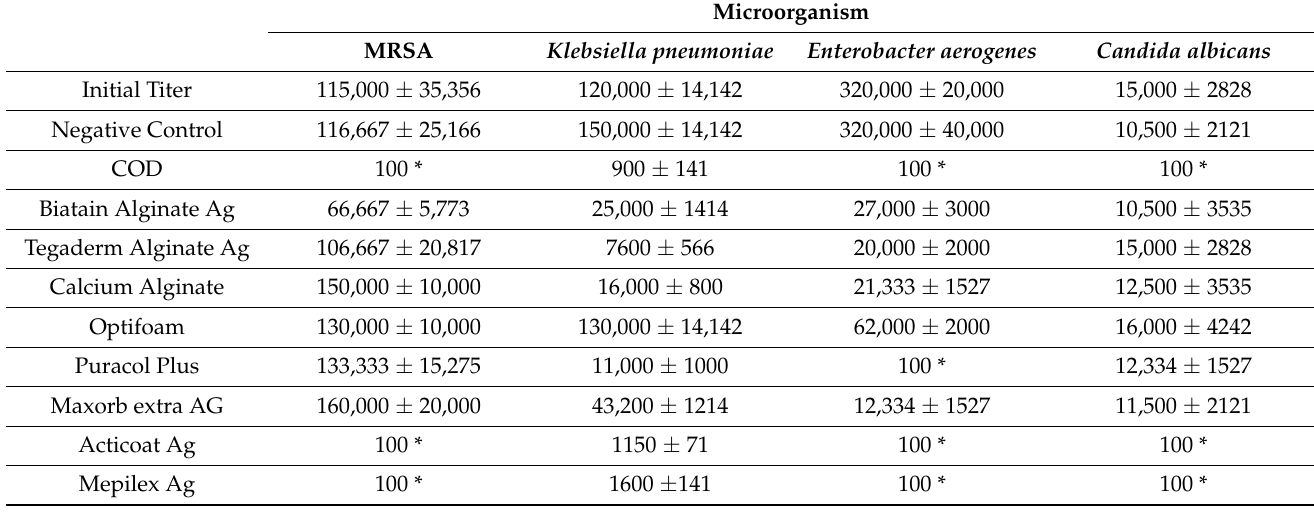
Table 1. Antimicrobial comparison between the COD and antimicrobial commercially available wound dressings containing silver. The initial titers spiked onto the dressings and the recovered viable titers after 1 h of incubation at 37 ◦ C are detailed (mean ± SD). * Lower limit of detection.